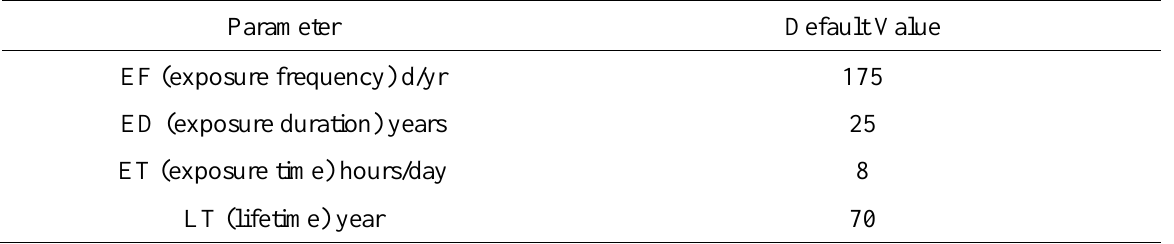
Table 1. Summary of USEPA standard default exposure